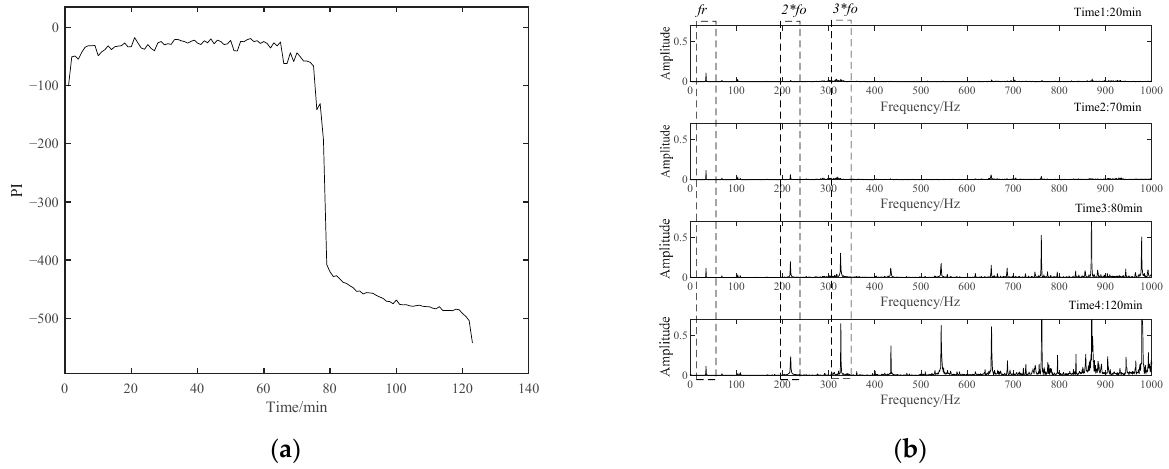
Figure 24. ( a ) The PI results of Bearing1-1; ( b ) envelop spectra of four representative moments.